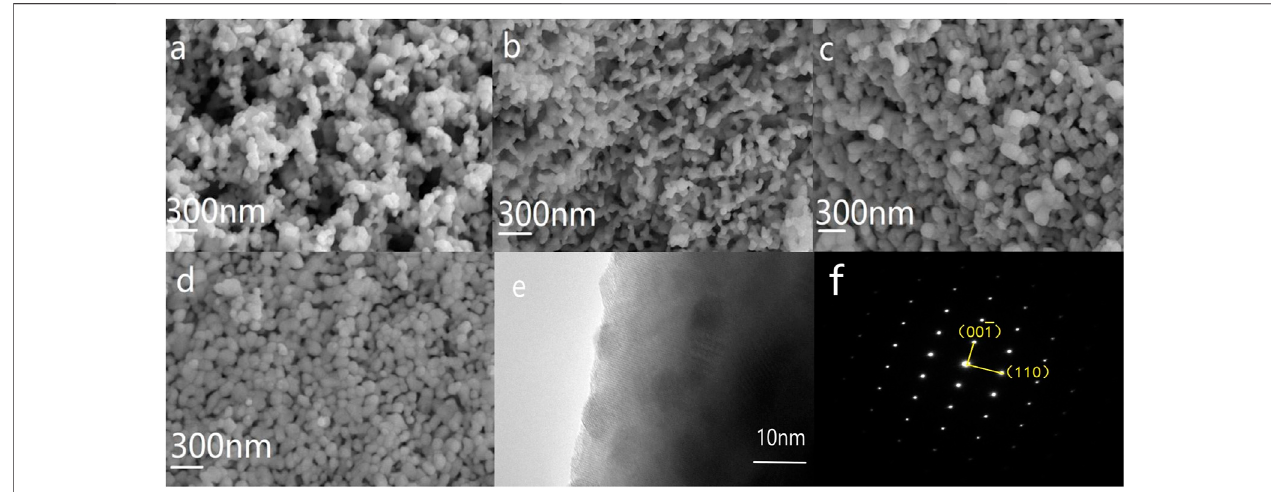
FIGURE3 | SEM images of BSFO powders doped with Eu at ratios of (A) 0.0, (B) 0.05, (C) 0.10, and (D) 0.15. TEM images ofBSFO – 15Eunanoparticles (E) , and (F) shows the SAED of BSFO – 15Eu nanoparticles and the belt axis is [1 (cid:1)